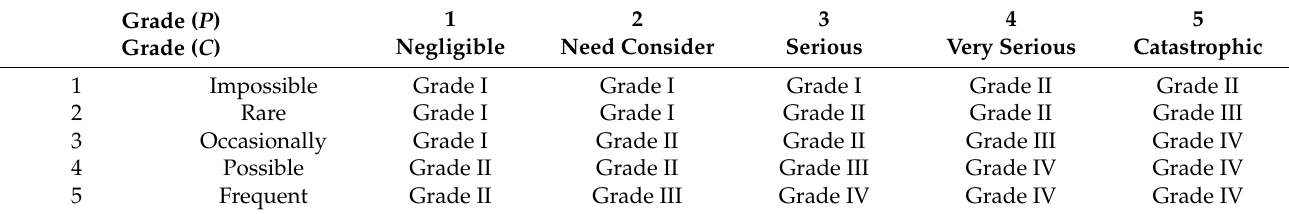
Table 1. Risk evaluation criteria for deep foundation pit